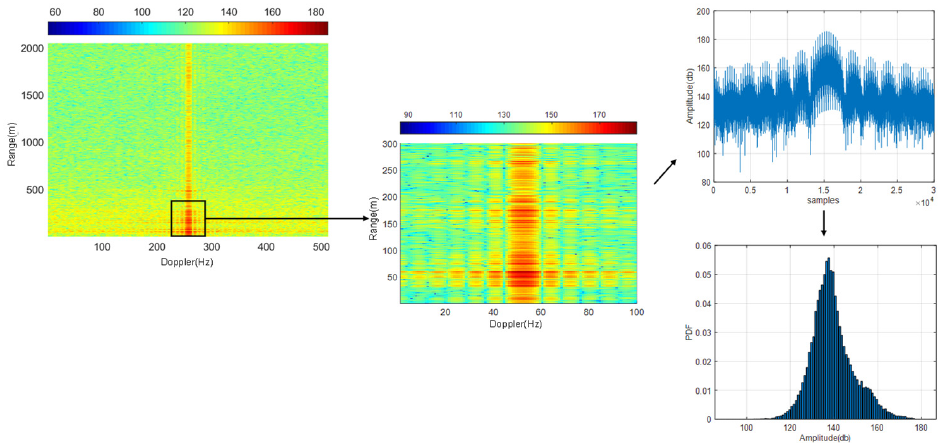
Figure 6. Schematic diagram of statistical parameter extraction of the range-Doppler map (Taking the dry grassland scene data as an example, 300 sample data are selected for the range unit, and 100 dimensions are chosen for the Doppler unit).